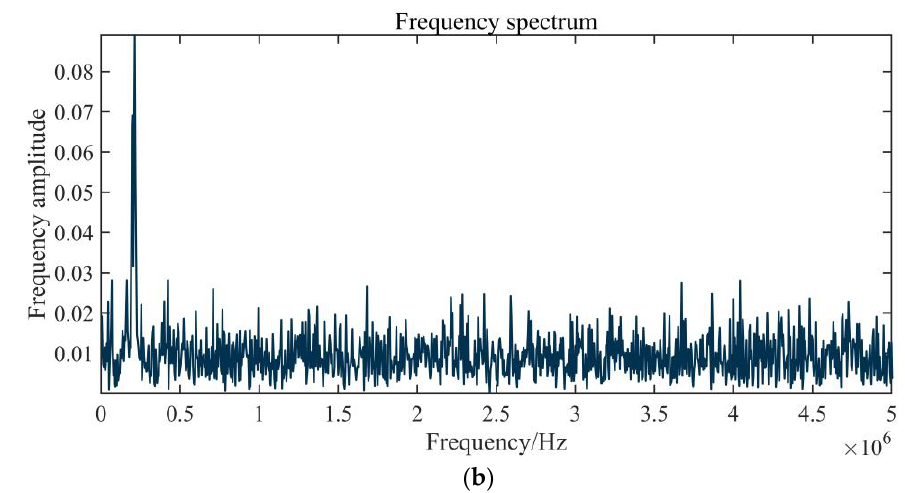
Figure 2. Influence of noise on an echo signal: ( a ) an echo signal with noise; ( b ) the signal frequency spectrum.